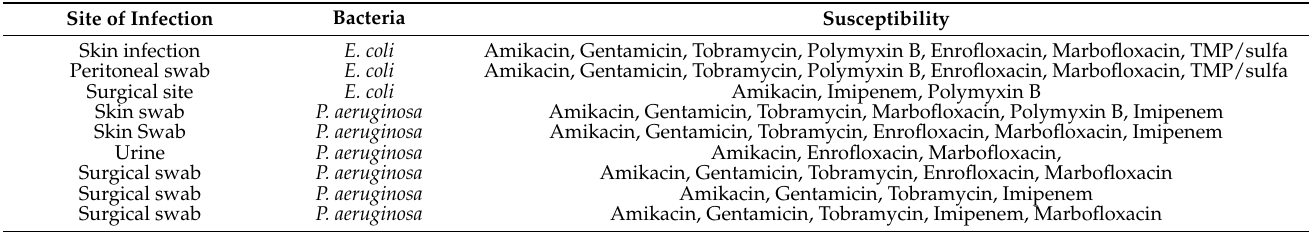
Table 3. Infections caused by opportunistic bacteria ( E. coli and P. aeruginosa ) and their susceptibility to antibiotics. Site of